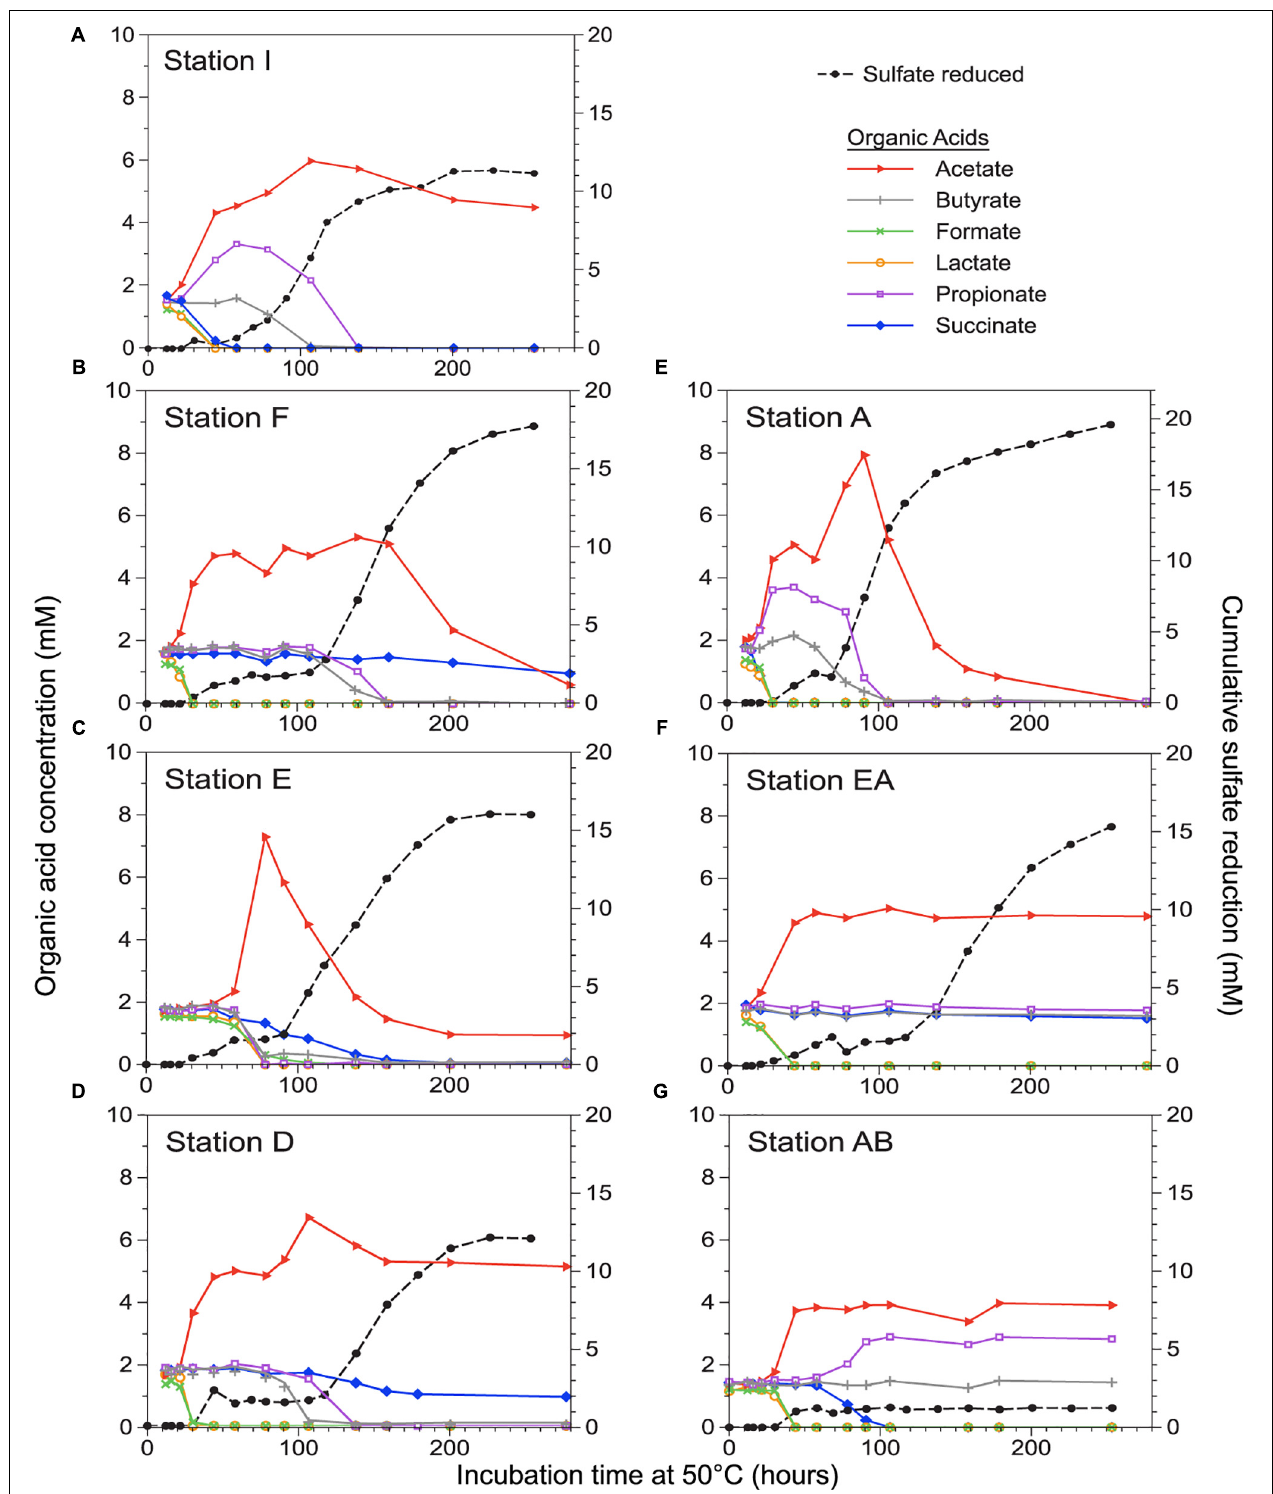
FIGURE 2 | Progress in sulfate reduction (measured on the right axis) and organic acid concentrations (measured on the left axis) over time in sediment incubations for seven out of ten stations (A–G) , ordered north to south. Organic acid concentrations were not determined for stations CN, BE, and AH (not shown; see Supplementary Table S1